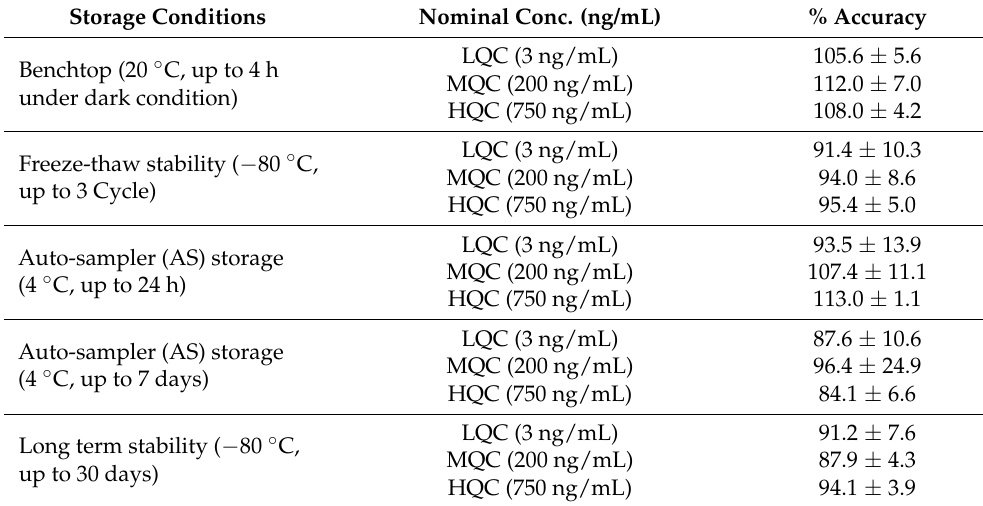
Table 5. Stability of ICG in rat plasma at different laboratory storage conditions (Mean ± SD, n = 3).